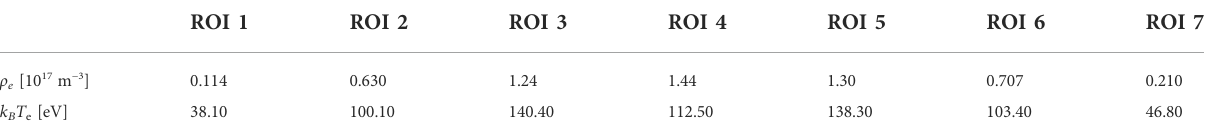
TABLE3Plasmaparameters, electrondensity ρ e [m − 3 ],andenergy k B T e [eV],estimatedfromnumericalsimulationsalongthelongitudinalz-axisofthe plasma chamber, for argon plasma con fi ned in minimum-B- fi eld, sustained by 12.84 GHz frequency and microwave power of 30 W.